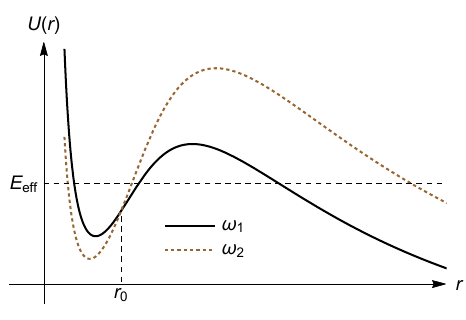
Figure 13 . Effective potential of gravi-scalarballs for different values of ω when a , b , and µ are fixed. In the plot ω 2 > ω 1